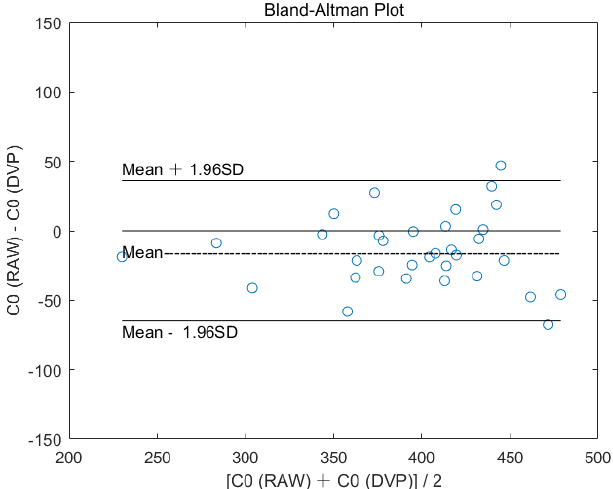
Figure 4. Bland–Altman plot showing good agreement between radial arterial waveform (i.e., measured from an air-pressure-sensing system) and digital volume pulse (i.e., measured from a six-channel ECG-PWV system) on C 0 for 33 elderly non-diabetic subjects.